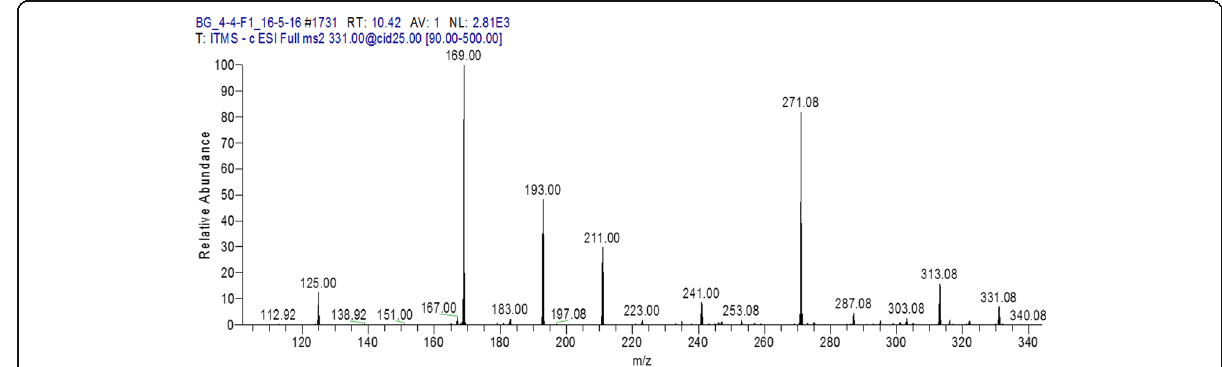
Fig. 2 LC MS/MS Chromatogram of fraction 4 (F4) from ethanol extract of P. granatum peel showing monogalloyl-hexoside and hexahydroxydiphenoyl-hexoside